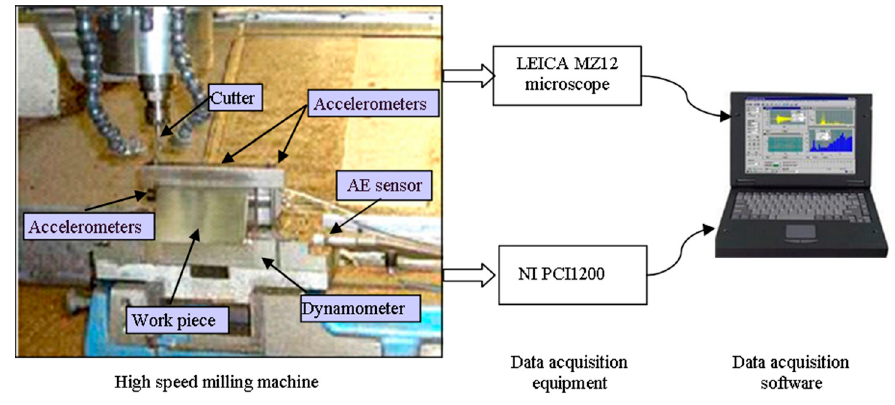
Figure 9. The experiment setup for tool wear monitoring